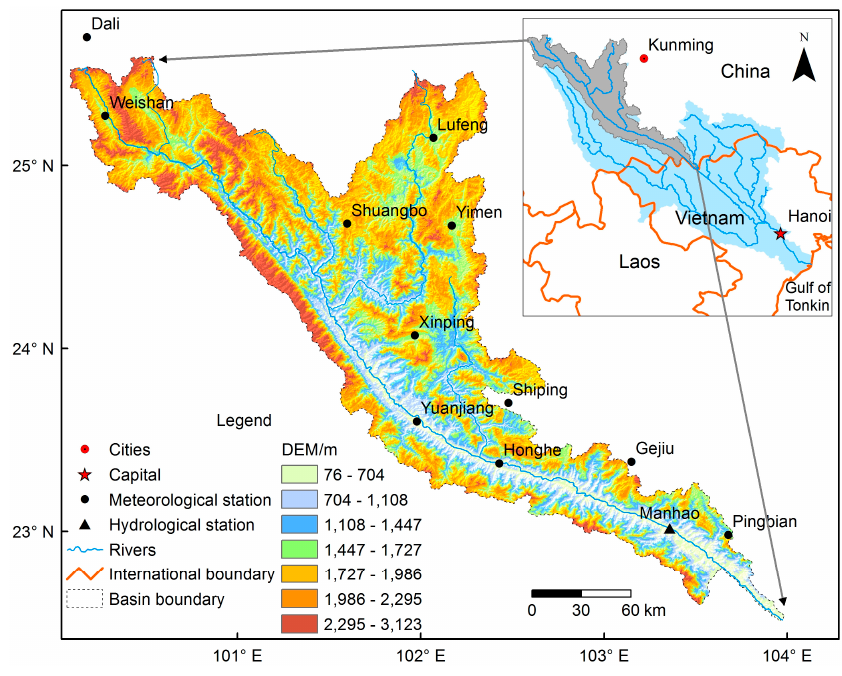
Figure 1. Location of the upper catchment of the Red River Basin (URRB) and distribution of meteorological and hydrological stations.